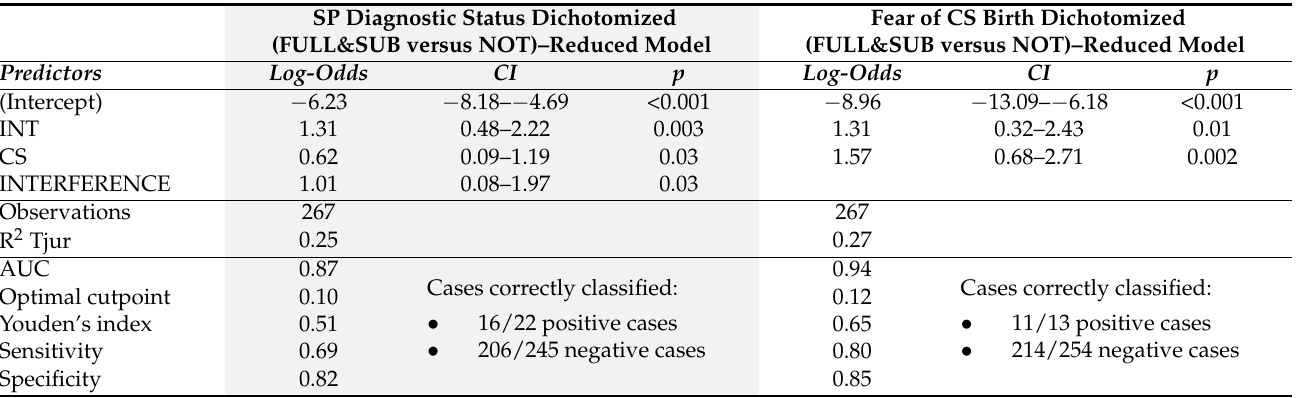
Table 6. Results of logistic regressions on Chidbirth Fear Questionnaire (CFQ) subscales for nulli- parous participants.